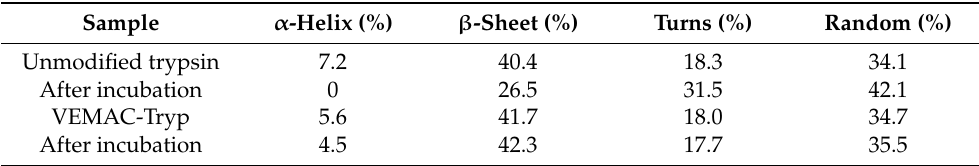
copolymer (VEMAC)-Tryp before and after incubation 1 .